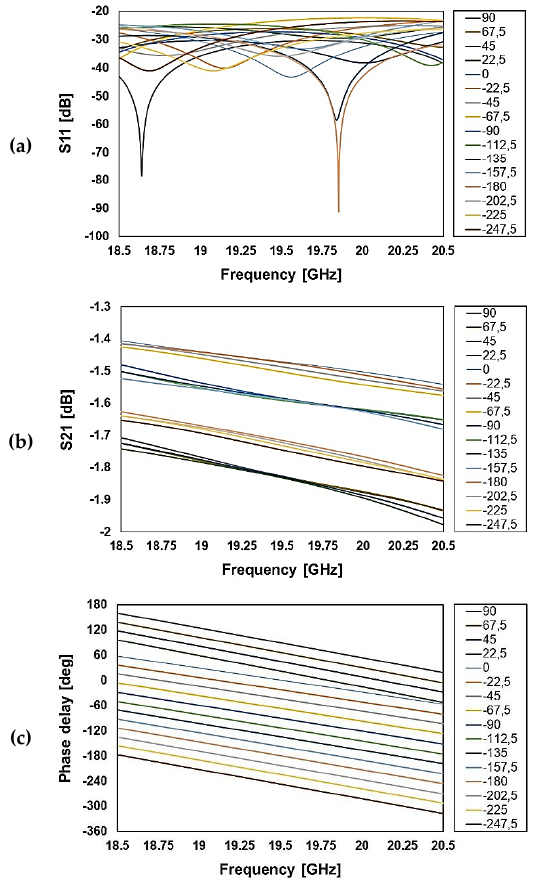
Figure 4. Simulated reflection ( a ), transmission ( b ), and phase shift ( c ) for several configurations of the K band RF-MEMS reconfigurable phase shifter (center frequency at 19.5 GHz). On the other hand, the device working at 29.3 GHz has simulated losses better than −2.4 dB for most configurations, despite at −90 and +90 phase shifts, −2.6 dB losses are observed at the maximum limit of 2 GHz frequency range (Ka band phase shifter; see Figure 5).